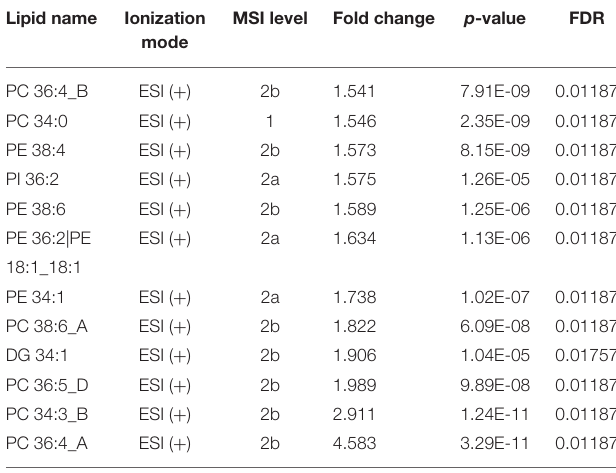
TABLE 1 | Increased lipids in SH-SY5Y cells after the treatment with olives leaves-sea sand adsorbate (OL-SS) at 40 µ g/mL in comparison to control conditions after